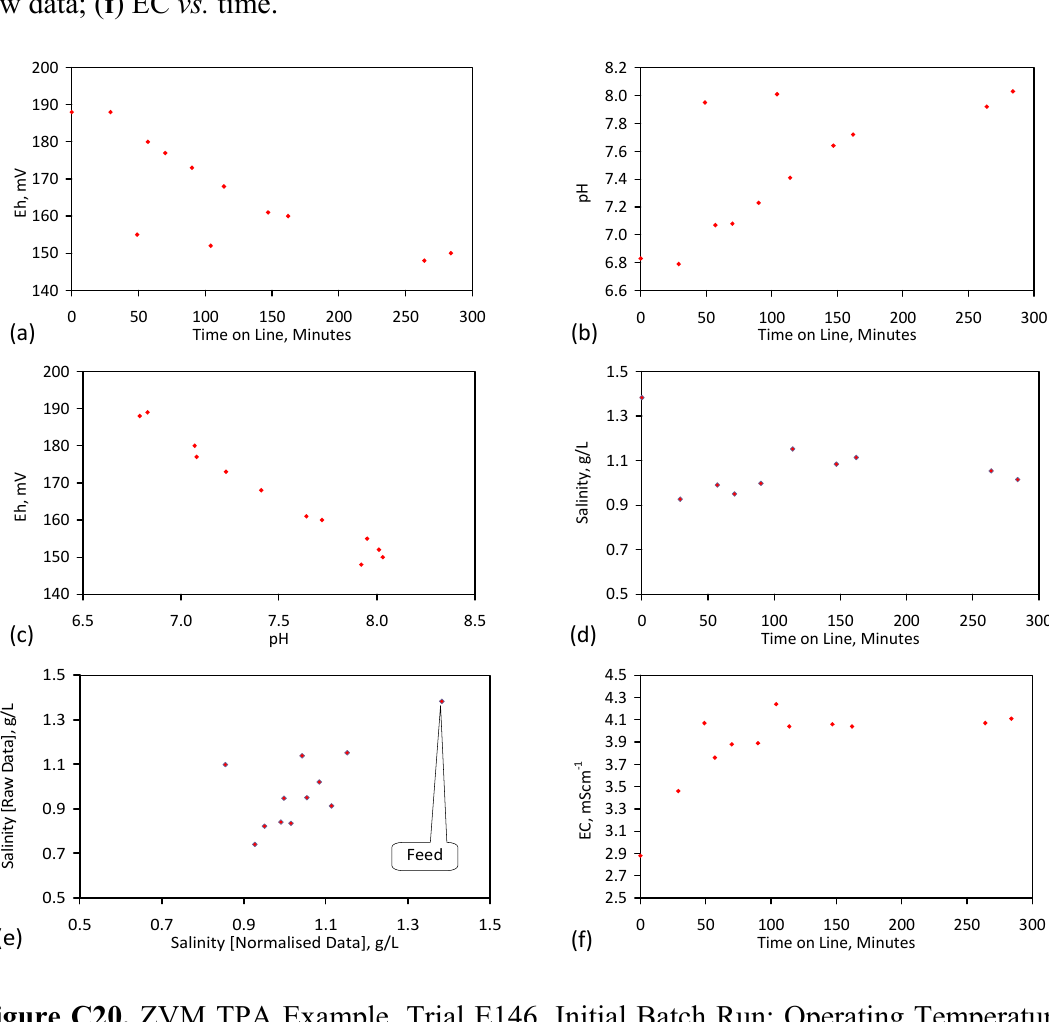
Figure C20. ZVM TPA Example, Trial E146. Initial Batch Run; Operating Temperature: 17–20 °C; Oxidising Environment: Water volume in the reactor = 0.24 m 3 ; ZVM TP in a cartridge = 0.4 kg. The cartridge (and ZVM TPA) had previously been used in Trial E145. Air flow = 120 L·h − 1 . ( a ) Eh vs. time; ( b ) pH vs. time; ( c ) pH vs. Eh; ( d ) Salinity vs. time; ( e ) Salinity calculated from normalised data vs. salinity calculated from raw data. ( f ) EC vs.